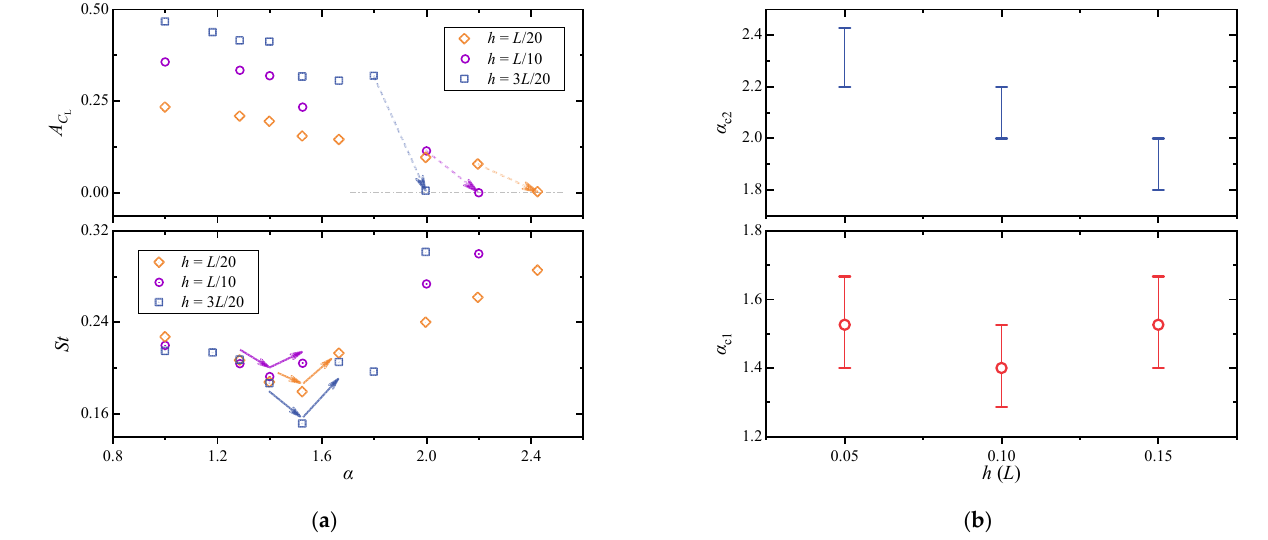
A and St , and ( b ) range of α c1 and α c2 . and St , and ( b ) range of α c1 and L